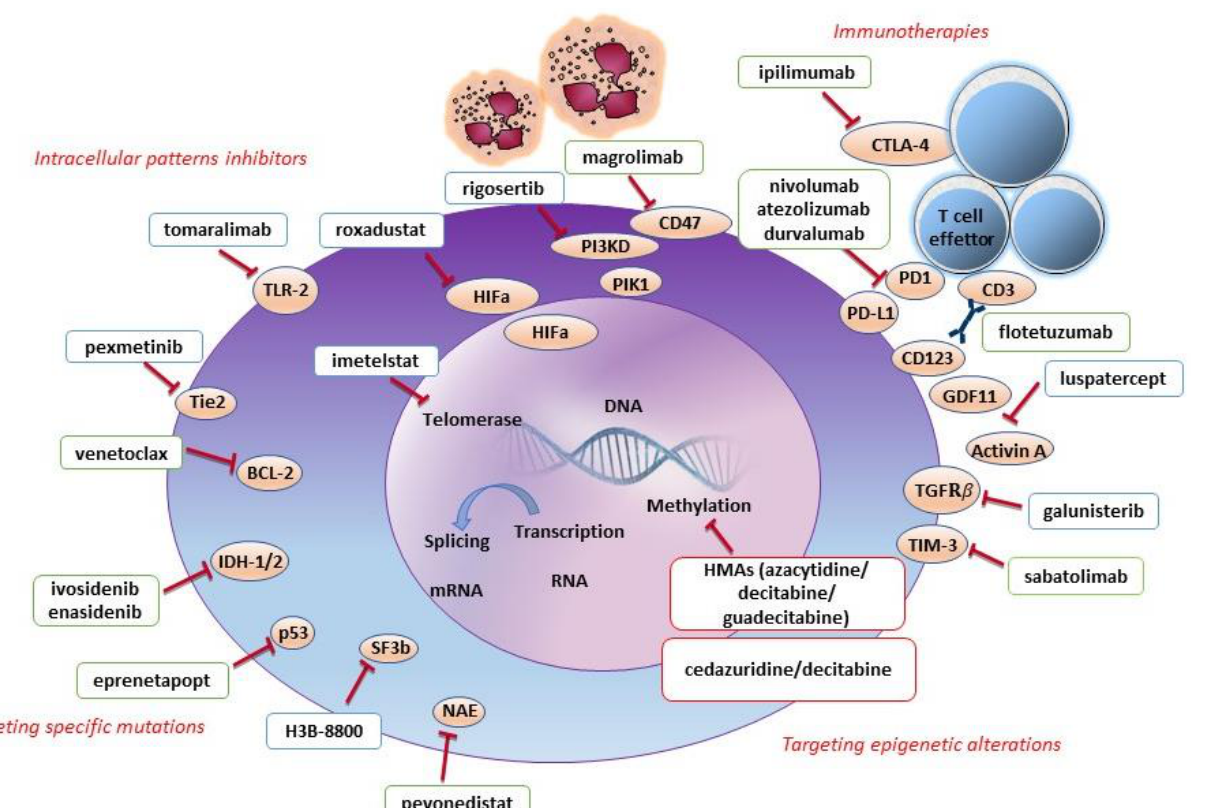
Figure 1. Novel therapies for myelodysplastic syndromes: immunologic, epigenetic and molecular targets. The physiopathology of myelodysplasia implies several pathogenic mechanisms, including epigenetic alterations, the disruption of intracellular molecular pathways, and the derangement of immunosurveillance that favors leukemic immune escape. All these pathogenic mechanisms may represent a target for novel drugs. For instance, immune checkpoint inhibitors, such as nivolumab, atezolizumab, durvalumab, ipilimumab, magrolimab, are able to restore T cells and adaptive and innate immunity to target dysplastic hematopoietic stem cells. Other immunotherapies include bispecific antibodies, such as flotetuzumab, and in the future, CART cells. Drugs that target intracellular pathways include luspatercept, galunisertib, sabatolimab, pevonedistat, imetelstat, pexmetinib, venetoclax, tomaralimab, roxadustat, and rigosertib and these act on various levels in cell maturation, survival/apoptosis, ineffective erythropoiesis, response to hypoxia, and telomeres elongation. Targeting epigenetic alteration by hypomethylating agents such as azacytidine, decitabine and novel agents (guadecitabine, decitabine/cedazuridine) restores MDS maturation. Finally, specific mutation inhibitors include H3B-8800, ivosidenib, enasidenib and eprenetapopt, which restore hematopoietic differentiation. Novel drugs for low-risk MDS are represented in blue boxes, drugs for high-risk MDS in green boxes and drugs for low-risk and high-risk MDS in red